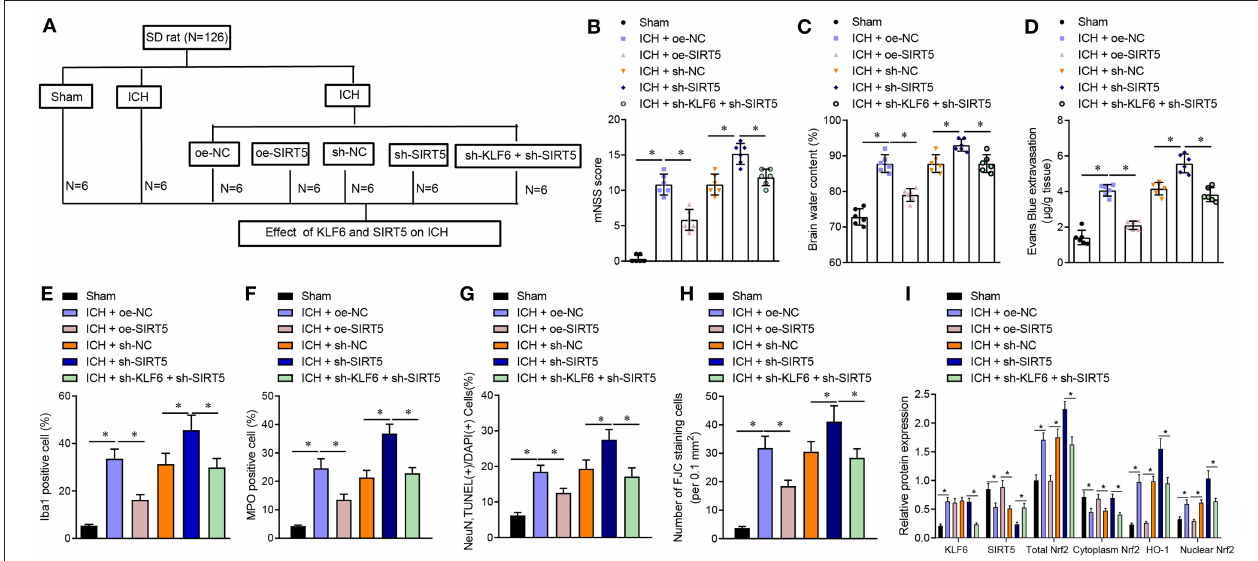
FIGURE 8 | KLF6 accelerates neurological dysfunction and hippocampal neuronal apoptosis and degeneration in ICH rats through SIRT5/Nrf2/HO-1 axis. (A) Different infection of ICH model rats. ICH rats were treated with oe-NC, oe-SIRT5, sh-NC, sh-SIRT5, and sh-SIRT5 + sh-KLF6. (B) The mNSS score of ICH rats. (C) Water content in brain tissues of ICH rats. (D) Evans blue penetration of brain tissues of ICH rats. (E) Microglia activation of ICH rats detected by immunofluorescence staining. (F) The activation of neutrophils of ICH rats detected by immunofluorescence staining. (G) The apoptosis of hippocampal neurons of ICH rats detected by TUNEL staining. (H) The degeneration of hippocampal neurons in the cerebral cortex of ICH rats detected by FJC staining. (I) The levels of KLF6, SIRT5, Nrf2 (total, cytoplasm, and nucleus), and HO-1 in the hippocampus of ICH rats detected by Western blot analysis. n = 6 rats/group. * p < 0.05. The measurement data were expressed as mean ± standard deviation. Comparisons between two groups were analyzed using unpaired t -test, and comparisons among multiple groups were tested by one-way ANOVA followed by Dunnett post-hoc test.